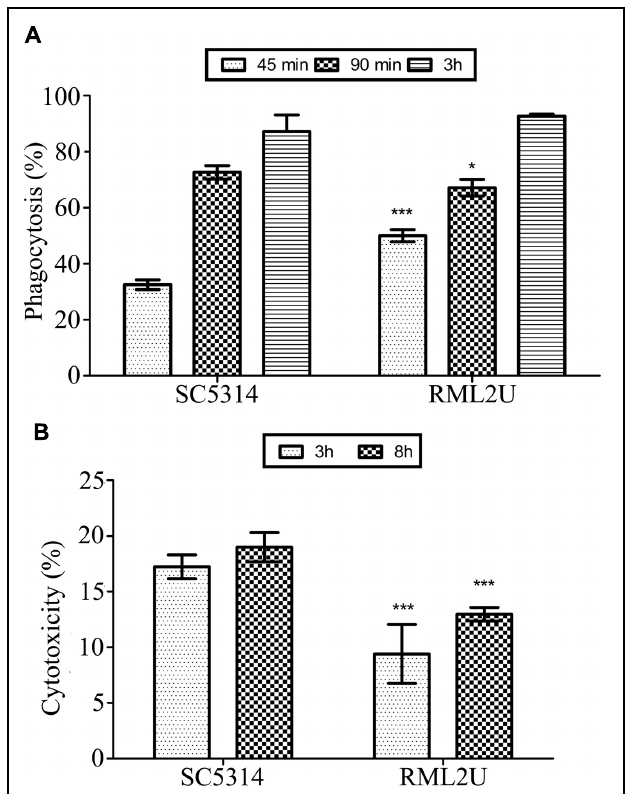
FIGURE 7 | Murine macrophage response to C. albicans strains. (A) Quantification of phagocytosis of C. albicans yeast at 45 min, 90 min and 3 h following co-incubation. (B) Cytotoxicity of the SC5314 and RML2U strains in RAW 264.7 macrophages at 3 and 8 h following co-incubation. Data are represented as the mean ± SD ( n = 3), and statistically significant differences relative to the wild-type are indicated ( ∗ p < 0.05; ∗∗∗ p <